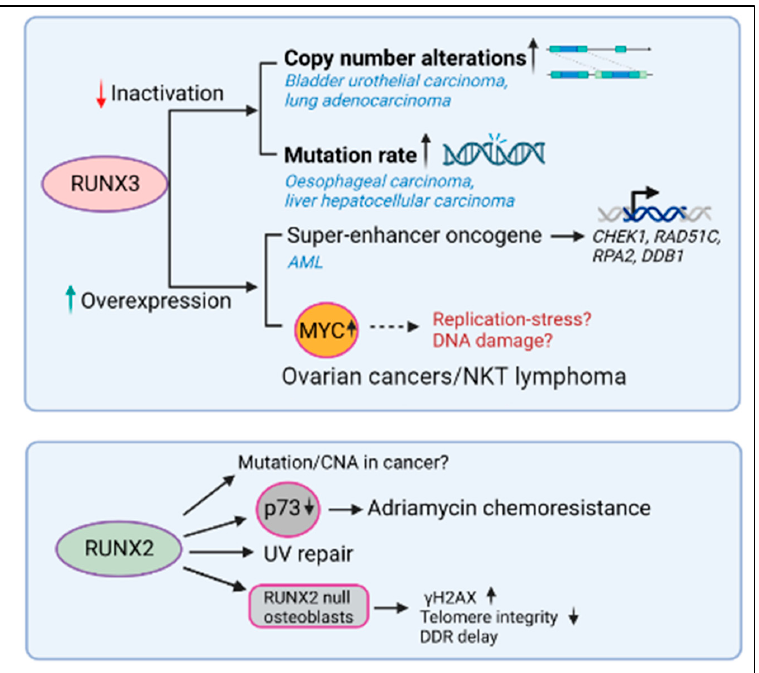
Figure 3. RUNX3 and RUNX3 dysregulation, DNA repair, and cancer. Lower RUNX3 transcript levels correlated with higher copy number alterations (CNAs) in bladder, urothelial carcinoma, and lung adenocarcinoma and with high mutation rate in esophageal carcinoma and liver hepatocellular carcinoma. In contrast, the higher levels of RUNX3 correlated with reduced DNA repair gene expression in AML and with higher levels of MYC in ovarian cancer and NKT cell lymphoma. While the expression of RUNX2 promoted the repair of UV-induced DNA damage and induced greater chemoresistance to adriamycin, the relationship between RUNX2 levels and mutational accumulation in the context of human malignancy remains unknown.